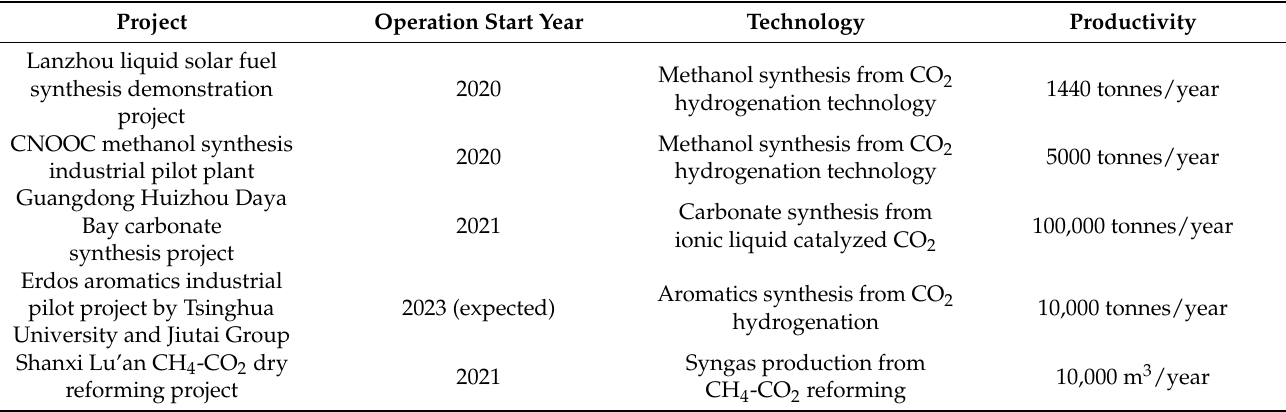
Table 5. CO 2 chemical utilization projects in China